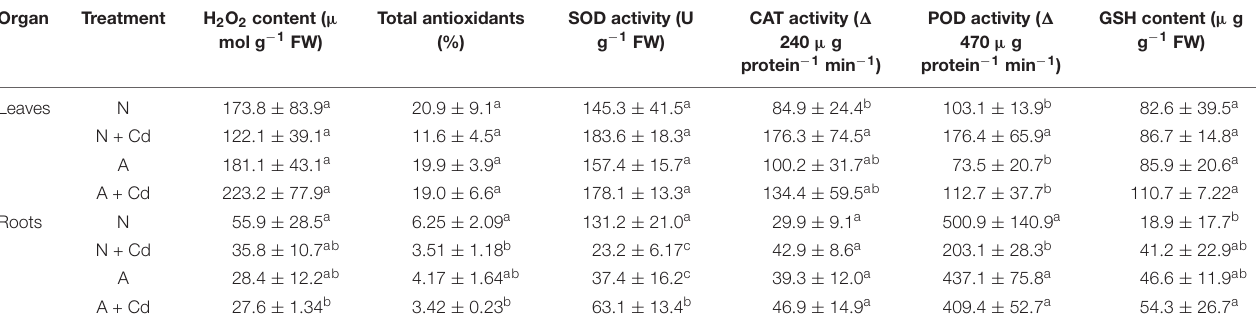
TABLE 3 | Effects of nitrate and ammonium on antioxidant defense systems in leaves and roots of sweet sorghum with or without Cd stress under buffered pH condition. Organ